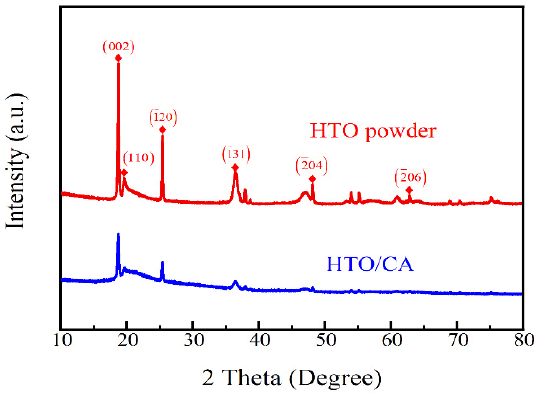
Figure 1. XRD patterns of the HTO powder and HTO/CA.